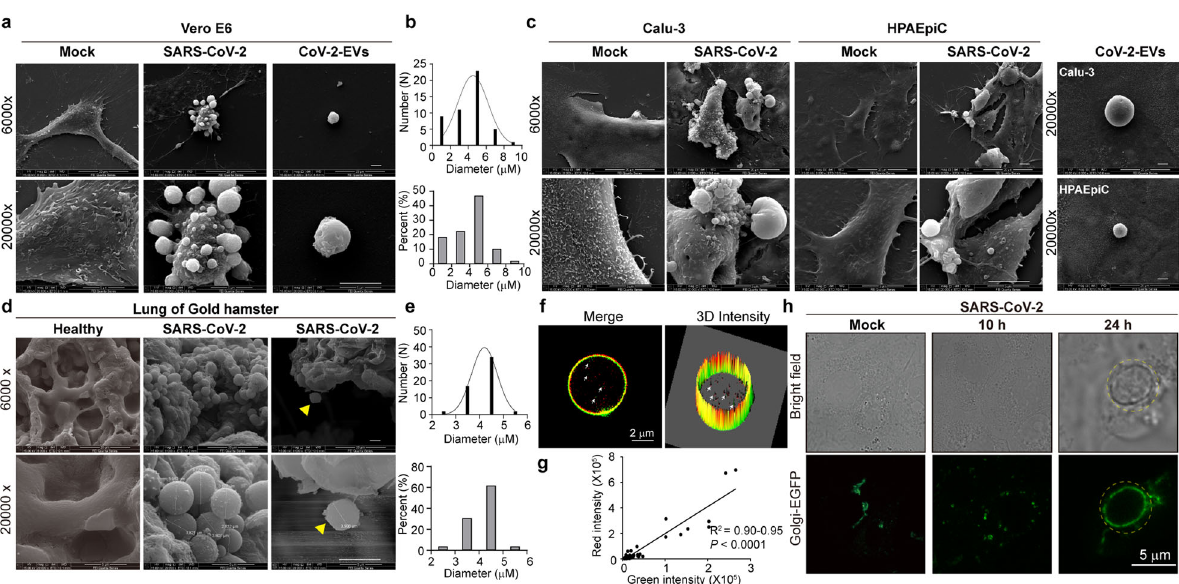
Fig. 2 SARS-CoV-2 induces secretion of extracellular vesicles. a SEM images of Vero E6 cells infected with SARS-CoV-2 (MOI = 1). b Diameters of vesicles derived from SARS-CoV-2-infected Vero E6 cells. Data are the means ± SEM. c SEM images of cells and EVs derived from Calu-3 (MOI = 2) and HPAEpiC cells (MOI = 5) infected with SARS-CoV-2. d SEM images of healthy golden hamster lung tissues and those infected with SARS-CoV-2. Yellow triangles, a shed vesicle from the damaged lung. e Diameter range of vesicles derived from SARS-CoV-2-infected golden hamster lung tissues. f Images of isolated 2-E-EVs showing co-transfected 2-E-mCherry and Golgi-EGFP (B4GALT1-EGFP). 2-E-mCherry is co-localized with the Golgi marker on 2-E-EV membranes. Interspersed Golgi apparatus were wrapped inside the isolated EVs (white arrows). g Linear regression analysis showing the correlation between red and green signals. h Vero E6 cells were transfected with Golgi-EGFP and then infected with SARS-CoV-2 (MOI = 1) (right). Images were captured at the indicated times after infection. Scale bars, 2 μ m ( f ), 5 μ m ( a , c , d , h